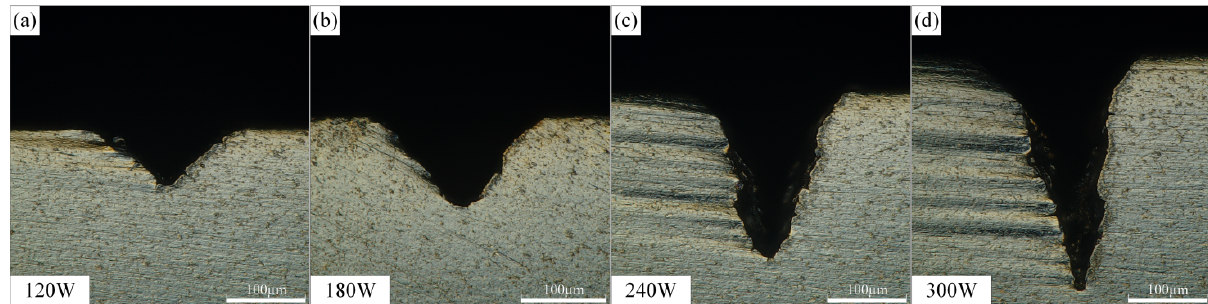
Figure 7. Effect of laser power on the microgroove morphology. ( a ) Laser power is 120 W, ( b ) Laser power is 180 W, ( c ) Laser power is 240 W, ( d ) Laser power is 300 W.